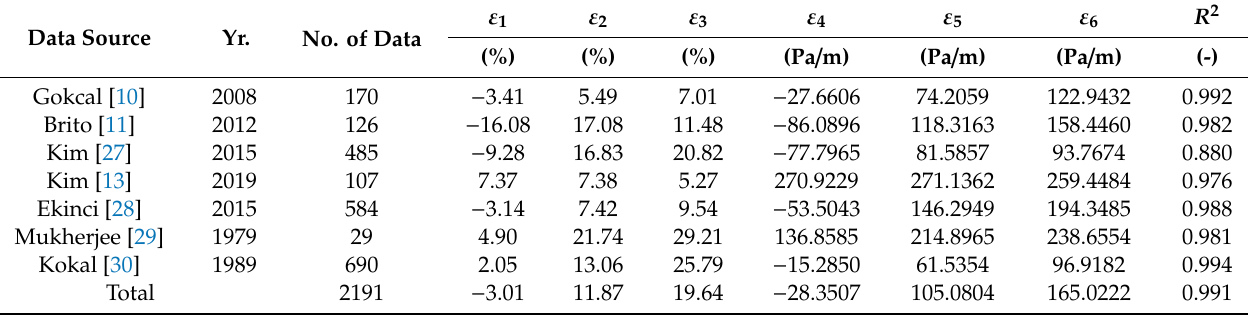
Table 8. Summary of the performance of current dp / dL